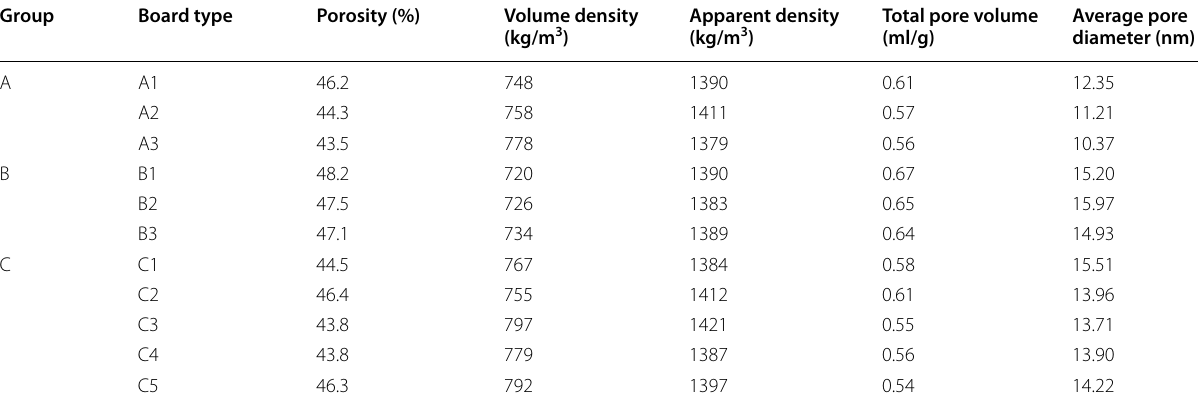
Table 3 Porosity of single layer TOCS particleboard